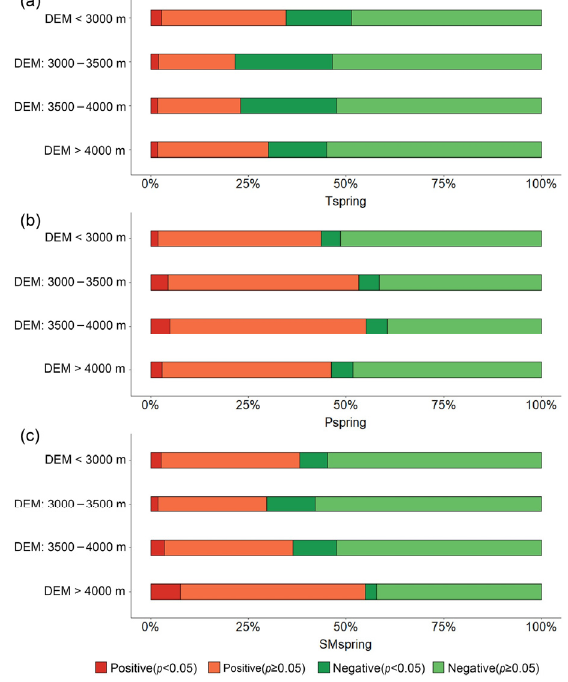
Figure 6. Percentages of correlation between SOS and three driving factors at different elevation zones. The three driving factors were ( a ) spring temperature (Tspring), ( b ) spring precipitation (Pspring), and ( c ) spring soil moisture (SMspring).